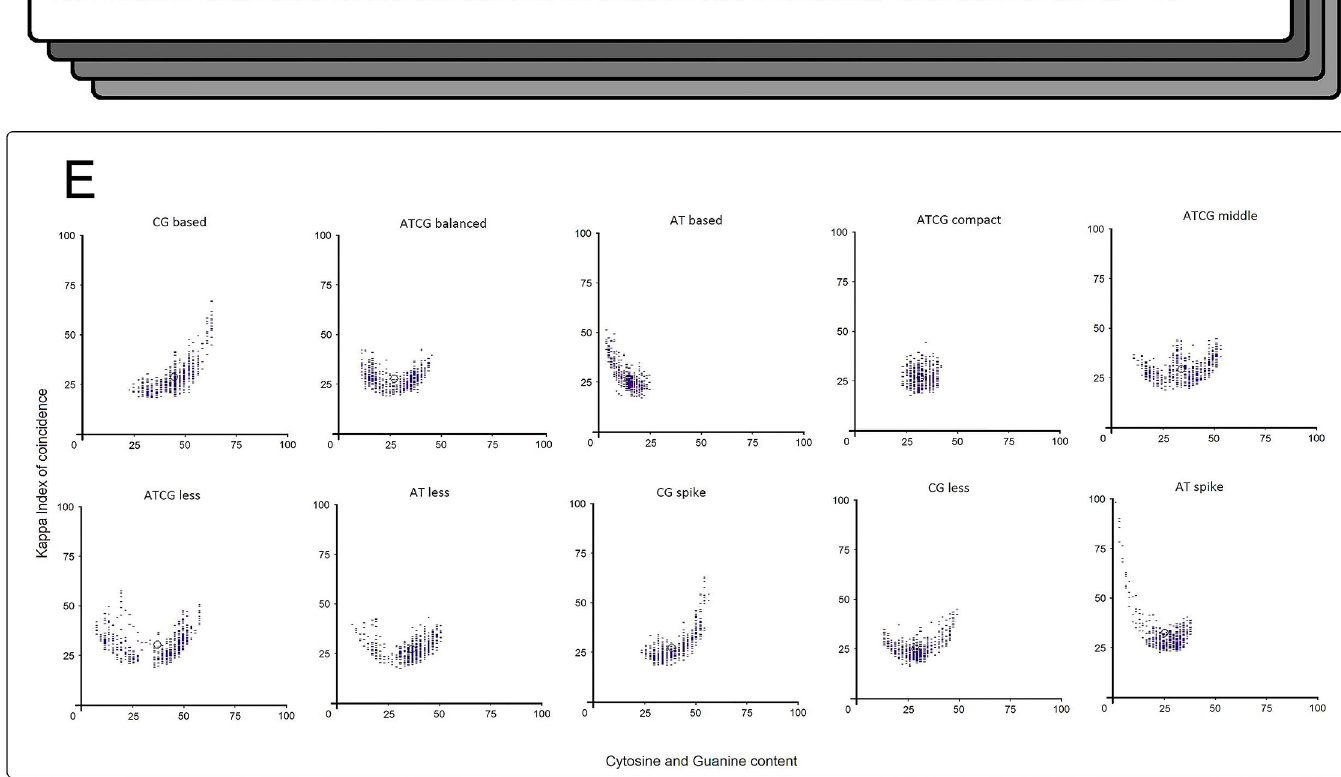
Fig 5. Schematic overview of the promoter analysis. (A) promoter sequences, (B) Kappa IC and (C+G)% values are extracted from each sliding window, (C) sliding window values plotted on a graph which shows a recognizable image-based pattern for each promoter sequence, (D) the center of weight of each promoter pattern plotted on a second graph in order to show the distribution of 8,515 promoters. Red color areas represent denser clusters of promoters. (E) The representative eukaryotic promoter classes are shown in the following sections: AT-based class, CG-based class, ATCG-compact class, ATCG- balanced class, ATCG-middle class, ATCG-less class, AT-less class, CG-spike class, CG-less class and ATspike class [57 – 59].